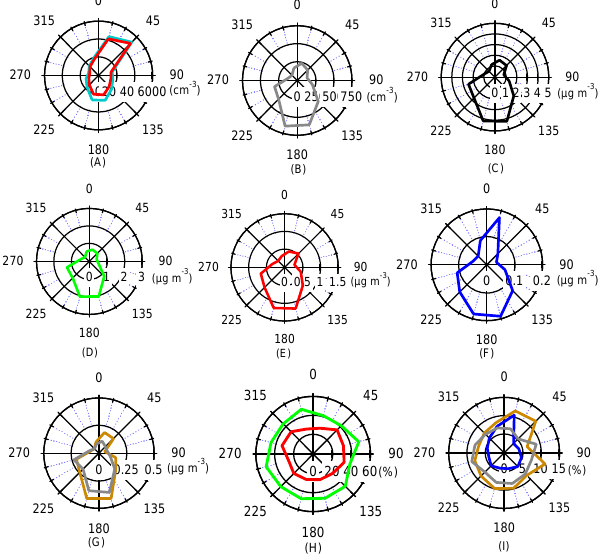
Figure 4. Diurnal profiles for chemical species, RH (in pink) and temperature (in dark). The upper and lower boundaries of the box are the 75th and 25th percentiles; the solid cycle curve marks the mean and the line in the box for median. The solid cycle curve in red is for sulfate and the open cycle curve in red is for sulfate after excluding the direct emissions of sulfate from the paper mill shown in the gray bar during 26–29 September in Fig.